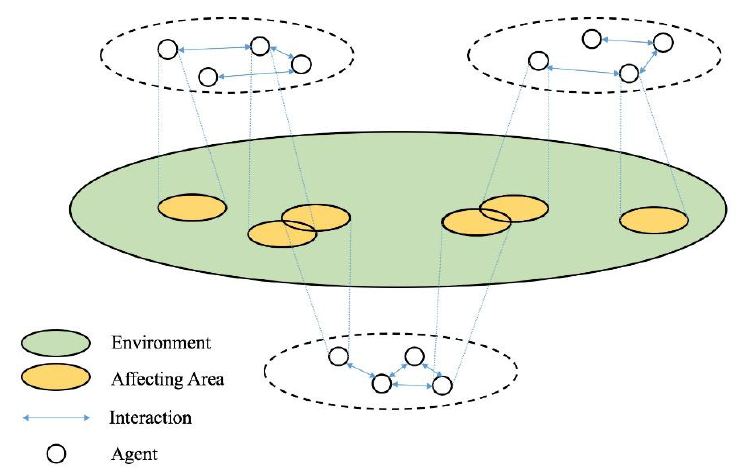
Figure 2. The standard framework of a multi-agent system.